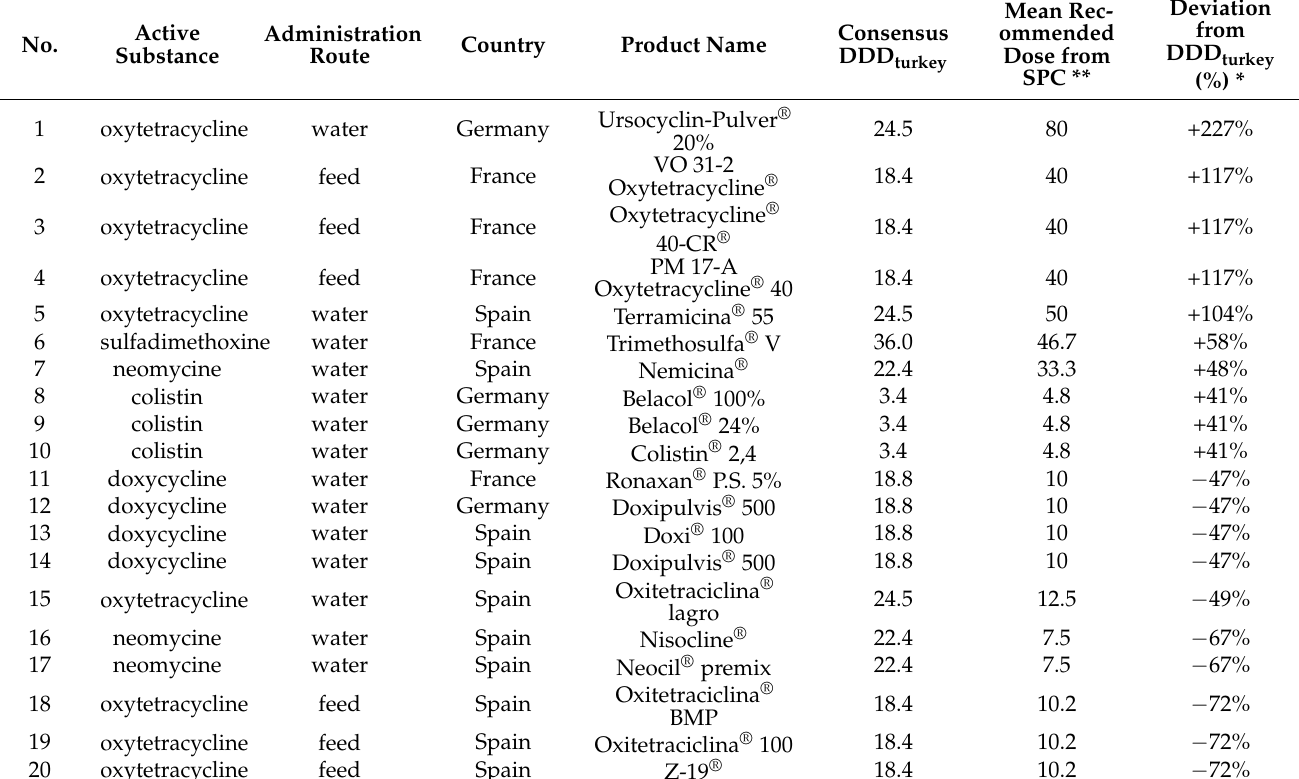
Table 2. The top 20 deviating products from the mean DDD turkey value (consensus DDD turkey